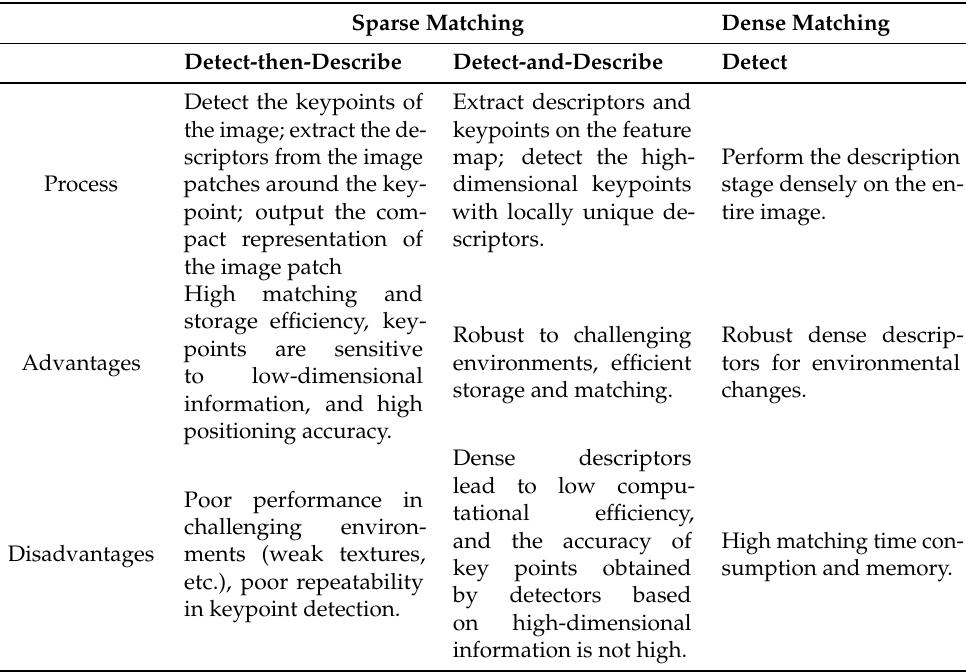
Figure 12. Schematic diagram illustrating the use of SIFT features for matching. Figure 4.13.Schematic diagram of using SIFT feature matching relationship Table 3. The process, advantages, and disadvantages of common sparse-matching methods and dense-matching